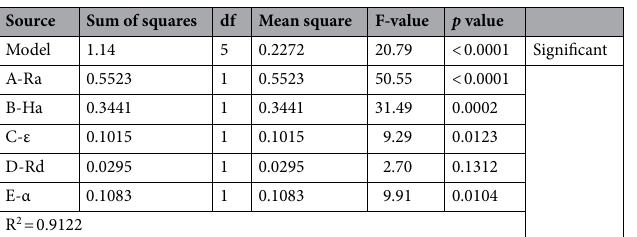
Source Sum of squares df Mean square F-value p value